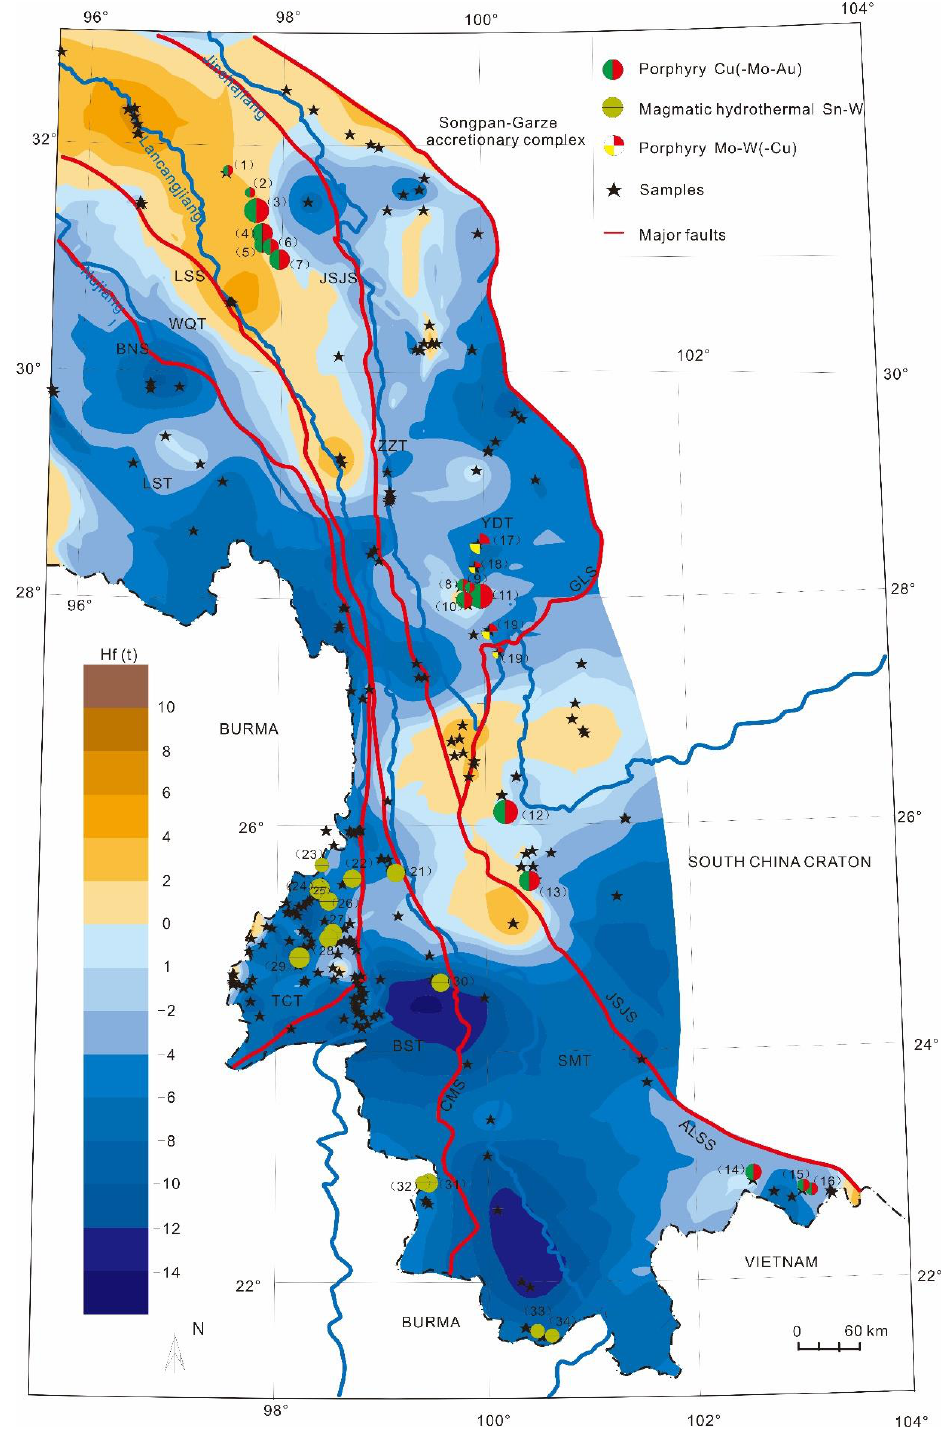
Figure 3. Hf isotopic contour maps showing the spatial variation of zircon ε Hf values for the Early Paleozoic to Cenozoic igneous rocks in the Sanjiang Tethyan Orogen. Abbreviations: BST = Baoshan terrane; EQT = Eastern Qiangtang terrane; LST = Lhasa terrane; SMT = Simao terrane; TCT = Tengchong terrane; WQT = Western Qiangtang terrane; YDT = Yidun arc terrane; ZZT = Zhongza terrane; ALSS = Ailaoshan Suture; BNS = Bangonghu – Nujiang Suture; CMS = Changning – Menglian Suture; JSJS = Jinshajiang Suture; GLS = Garzê – Litang Suture; LSS = Longmucuo – Shuanghu Suture.